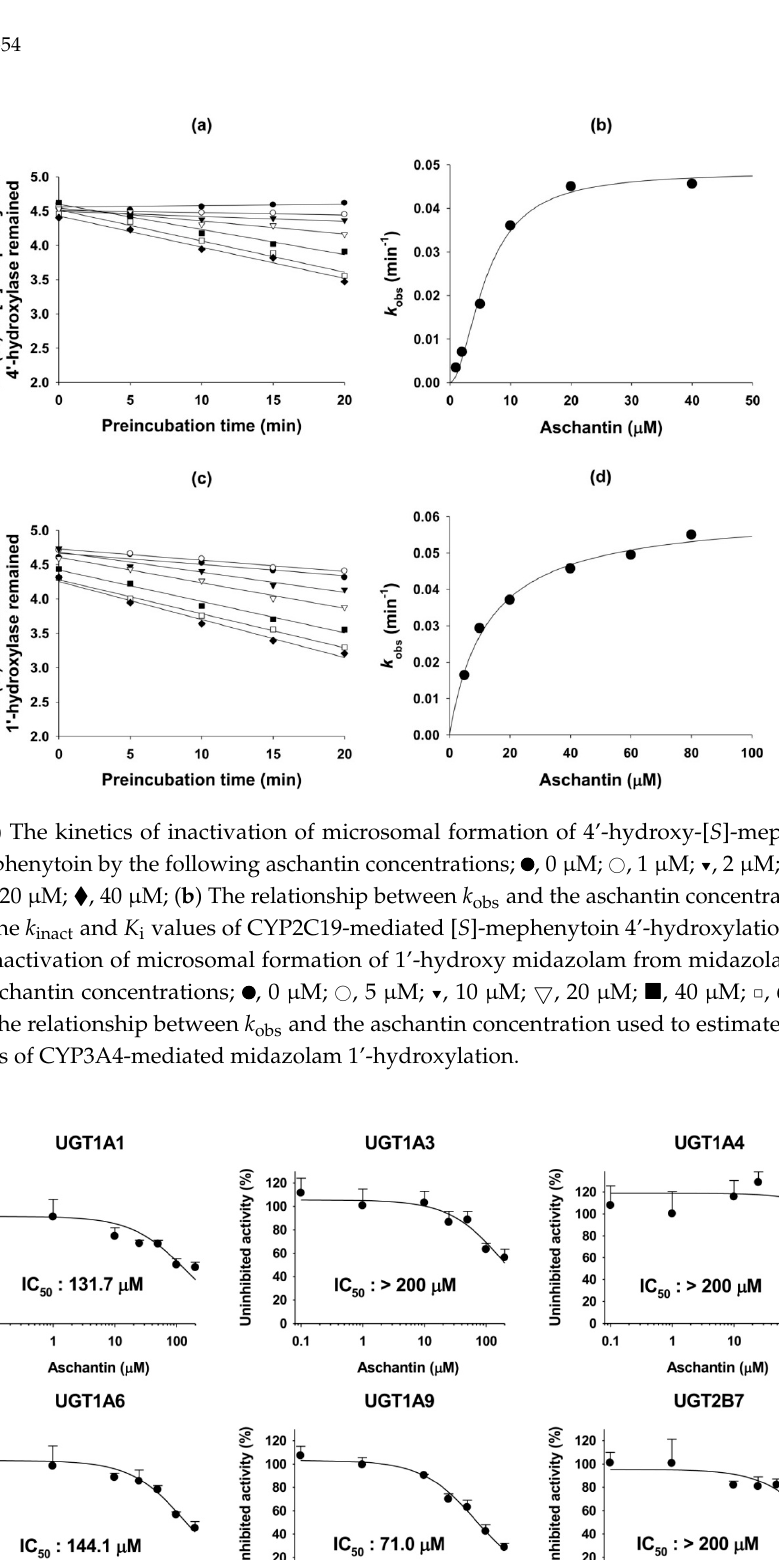
Molecules 2016 , 21 , 5 4 of 10 Figure 3. ( a ) Kinetics of inactivation of microsomal formation of N -de-ethylamodiaquine from amodiaquine by the following aschantin concentrations:  , 0 µM;  , 1 µM;  , 2 µM;  , 4 µM;  , 8